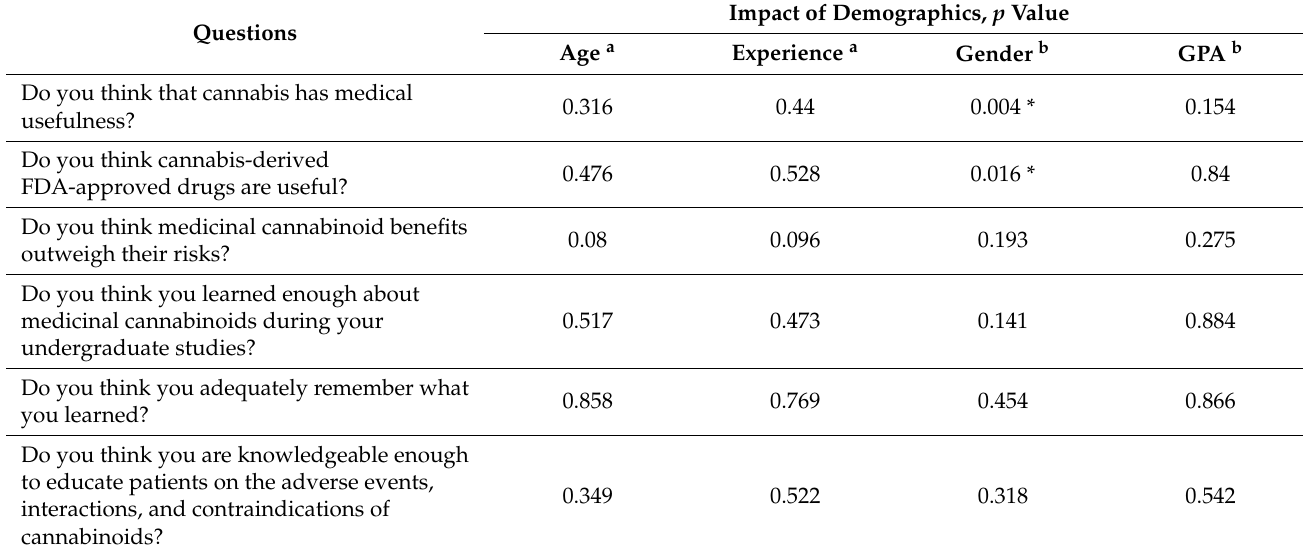
Table 3. Impact of demographics on participant